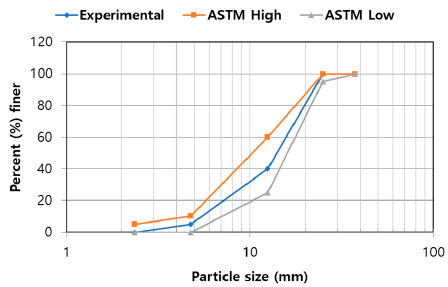
Figure 5. Gradation curves for coarse aggregates and ASTM C33 grading requirements for No. 57 aggregate. Figure